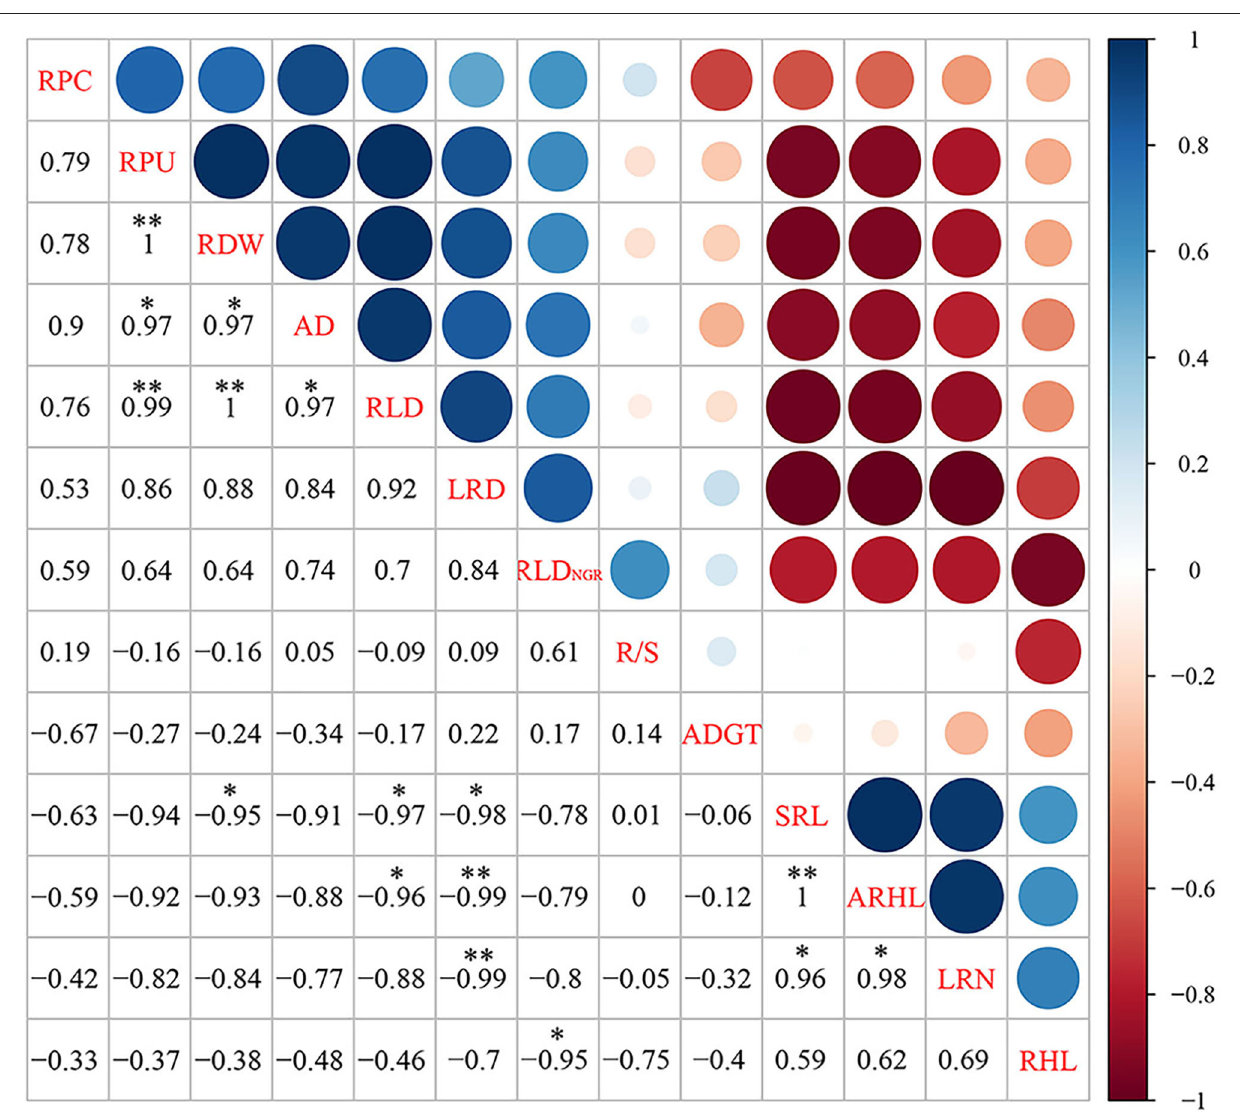
FIGURE 9 | The matrix of Spearman’s correlation coefficients and 95% confidential intervals among root and shoot morphology indices. The significance level of correlations is indicated as follows: * P < 0.05; ** P < 0.01. RPC, root phosphorus content; RPU, root phosphorus uptake; RDW, root dry weight; R/S, root/shoot ratio; ADGT, average daily growth of taproots; RLD NGR , net growth rate per unit volume; RLD, root length density per unit volume; LRN, number of lateral roots; LRD, lateral root branching density; AD, average root diameter; ARHL, average root hair length; RHL, root hair life span; SRL, specific root